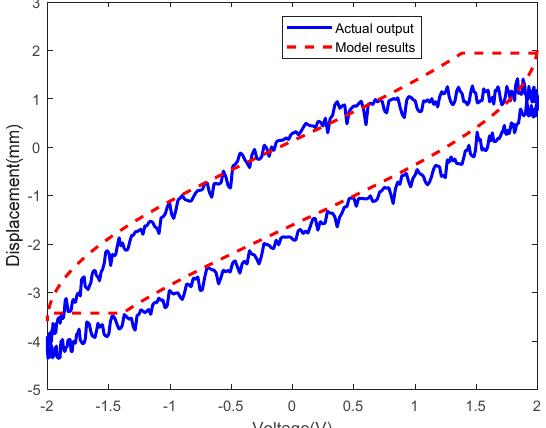
Figure 14. Structure of the proposed Prandtl ‐ Ishlinskii model. Figure 15. Structure of the proposed Prandtl-Ishlinskii model.